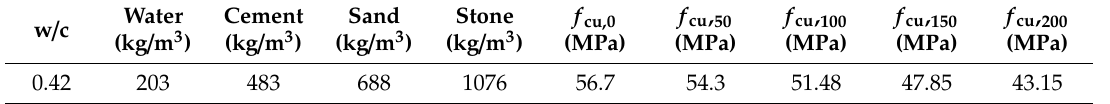
Table 2. Composition and strength of concrete (units: kg/m 3 and MPa).